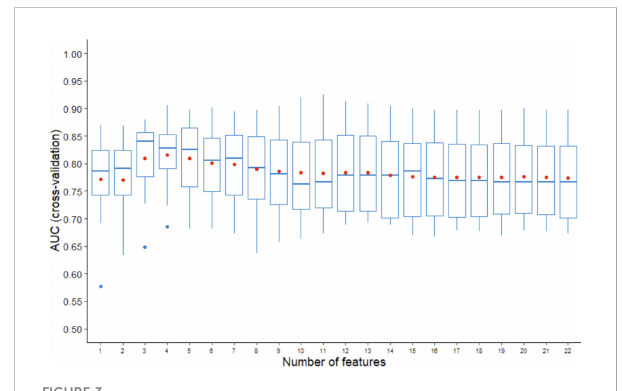
FIGURE 3 AUCs of three random runs of 5-fold cross validation using LDA- RFE. The line in box represents the median, and the red dot represents the average.